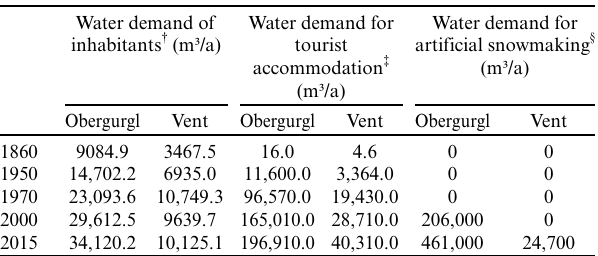
Table 6 . Water demand in Obergurgl and Vent for the five historical time